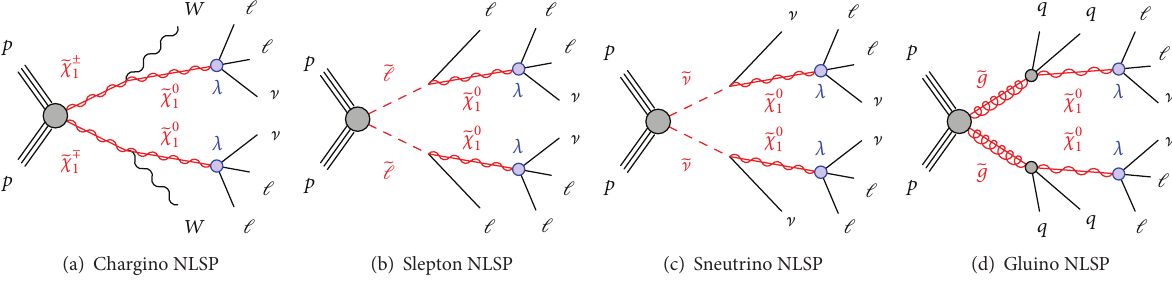
Figure 3: Representative diagrams for the RPV simplified models based on electroweak or gluino production (from